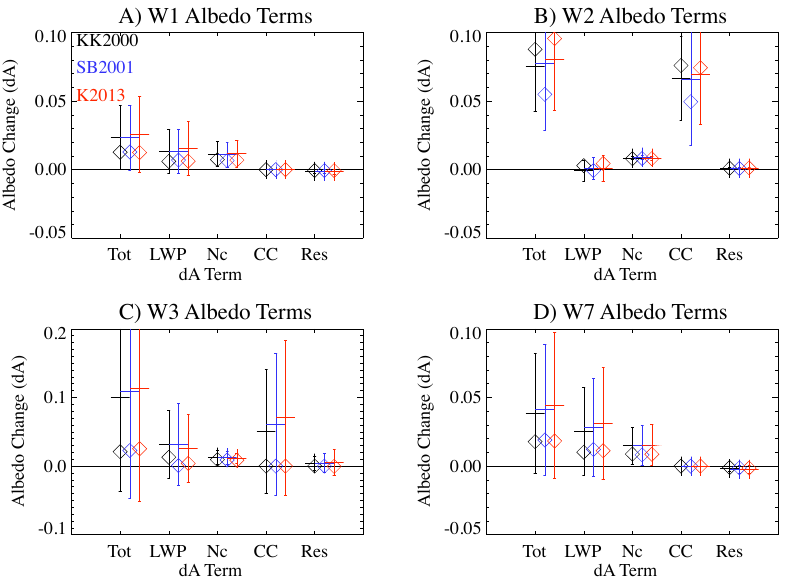
Figure 5. As for Fig. 3 but for standard case (KK2000) in black and two other autoconversion schemes: SB2001 (blue) and K2013 (red); see text for